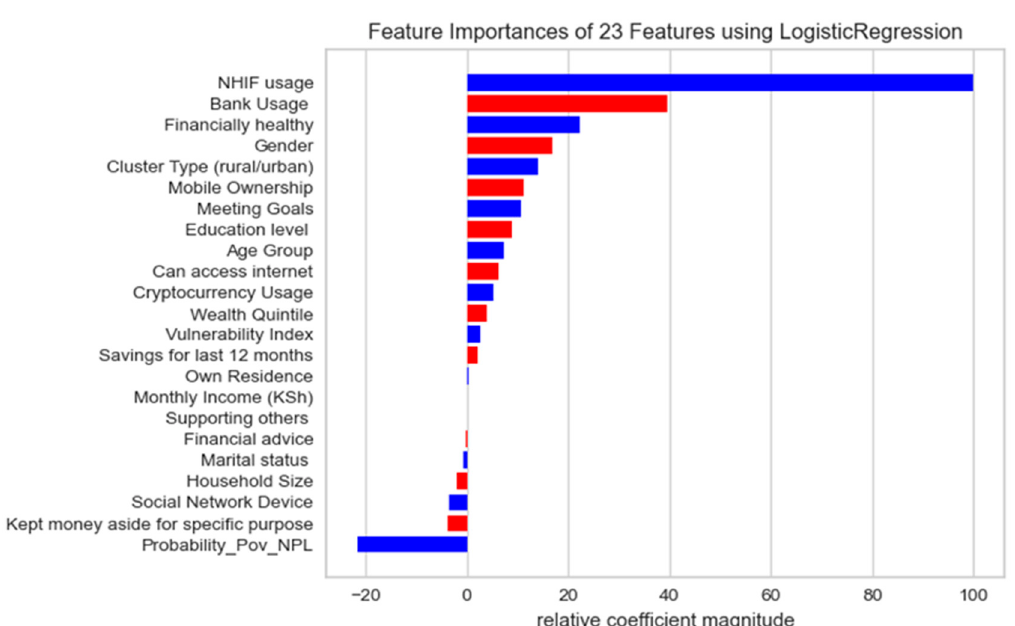
Figure 9. Feature importance from the logistic regression classifier.